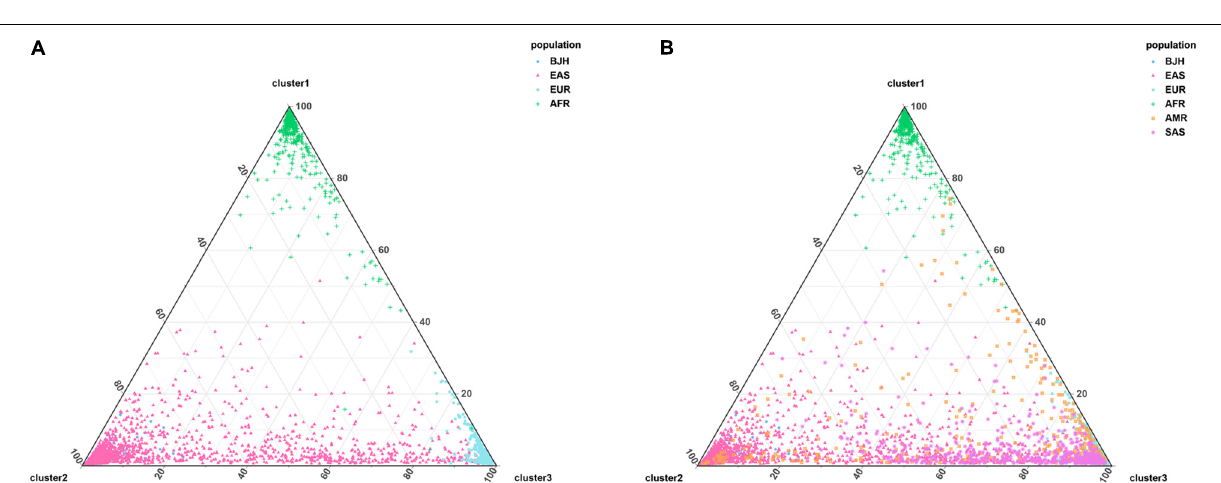
FIGURE 6 | The result of population genetic structure analysis on the individual level among the Beijing Han population and 31 reference populations.